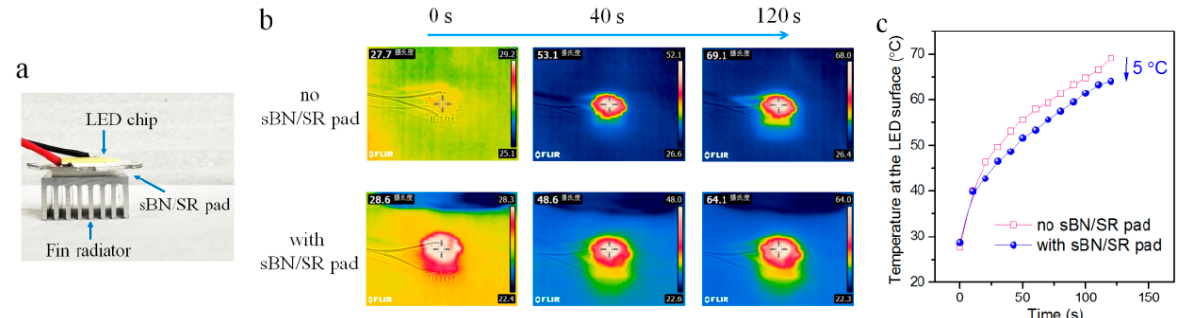
Figure 9. Demonstration of the thermal interface applications of sBN/SR composites. ( a ) Photograph showing the thermal interface application. ( b ) Thermal infrared images of the devices with or without sBN/SR composites. ( c ) The recorded maximum temperature on the light ‐ emitting diode (LED) chip surface.